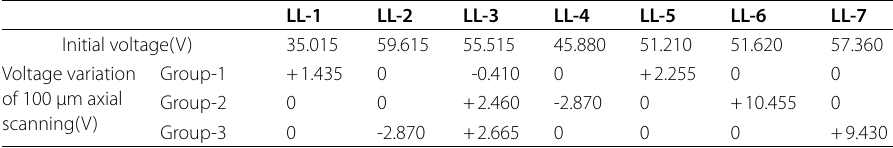
Table 1 Voltages corresponding to scanning 100 μm axial depth